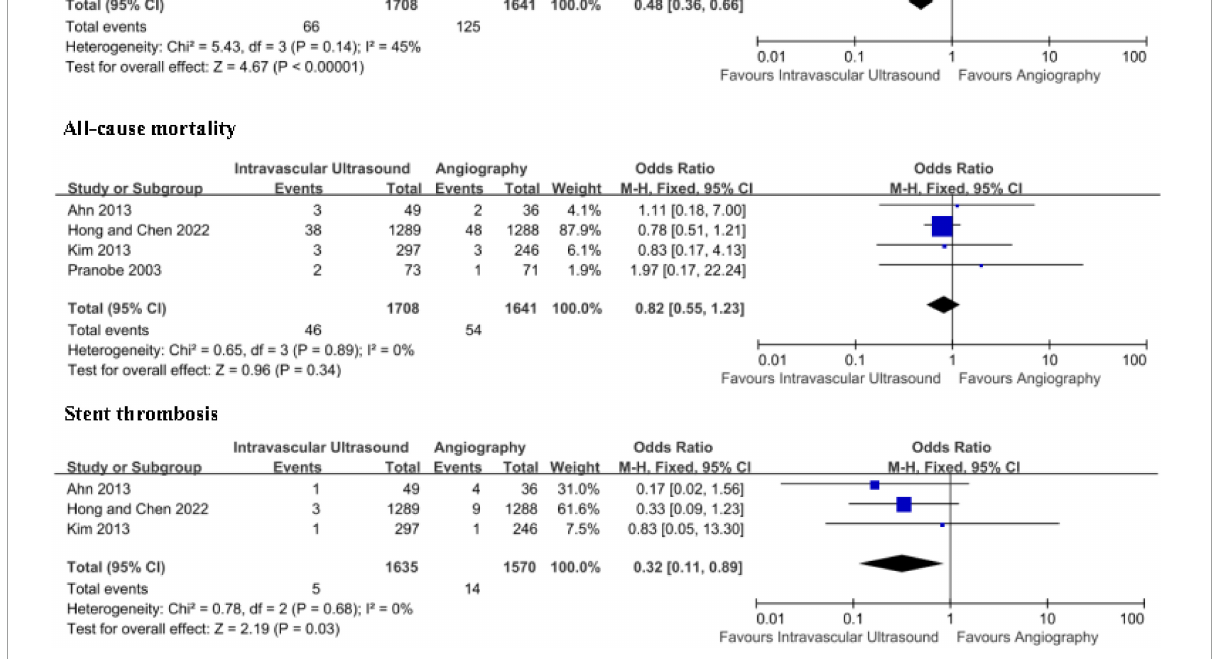
FIGURE2 All long clinical outcomes forest plot–random effect including major adverse cardiovascular events (MACE); All myocardial infarction; All revascularization; All-cause mortality; Stent thrombosis.